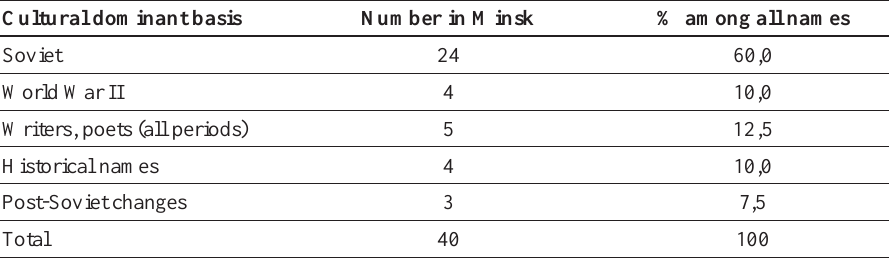
Table 1. Toponymy of major streets, parks, squares Cultural dominant basis Number in